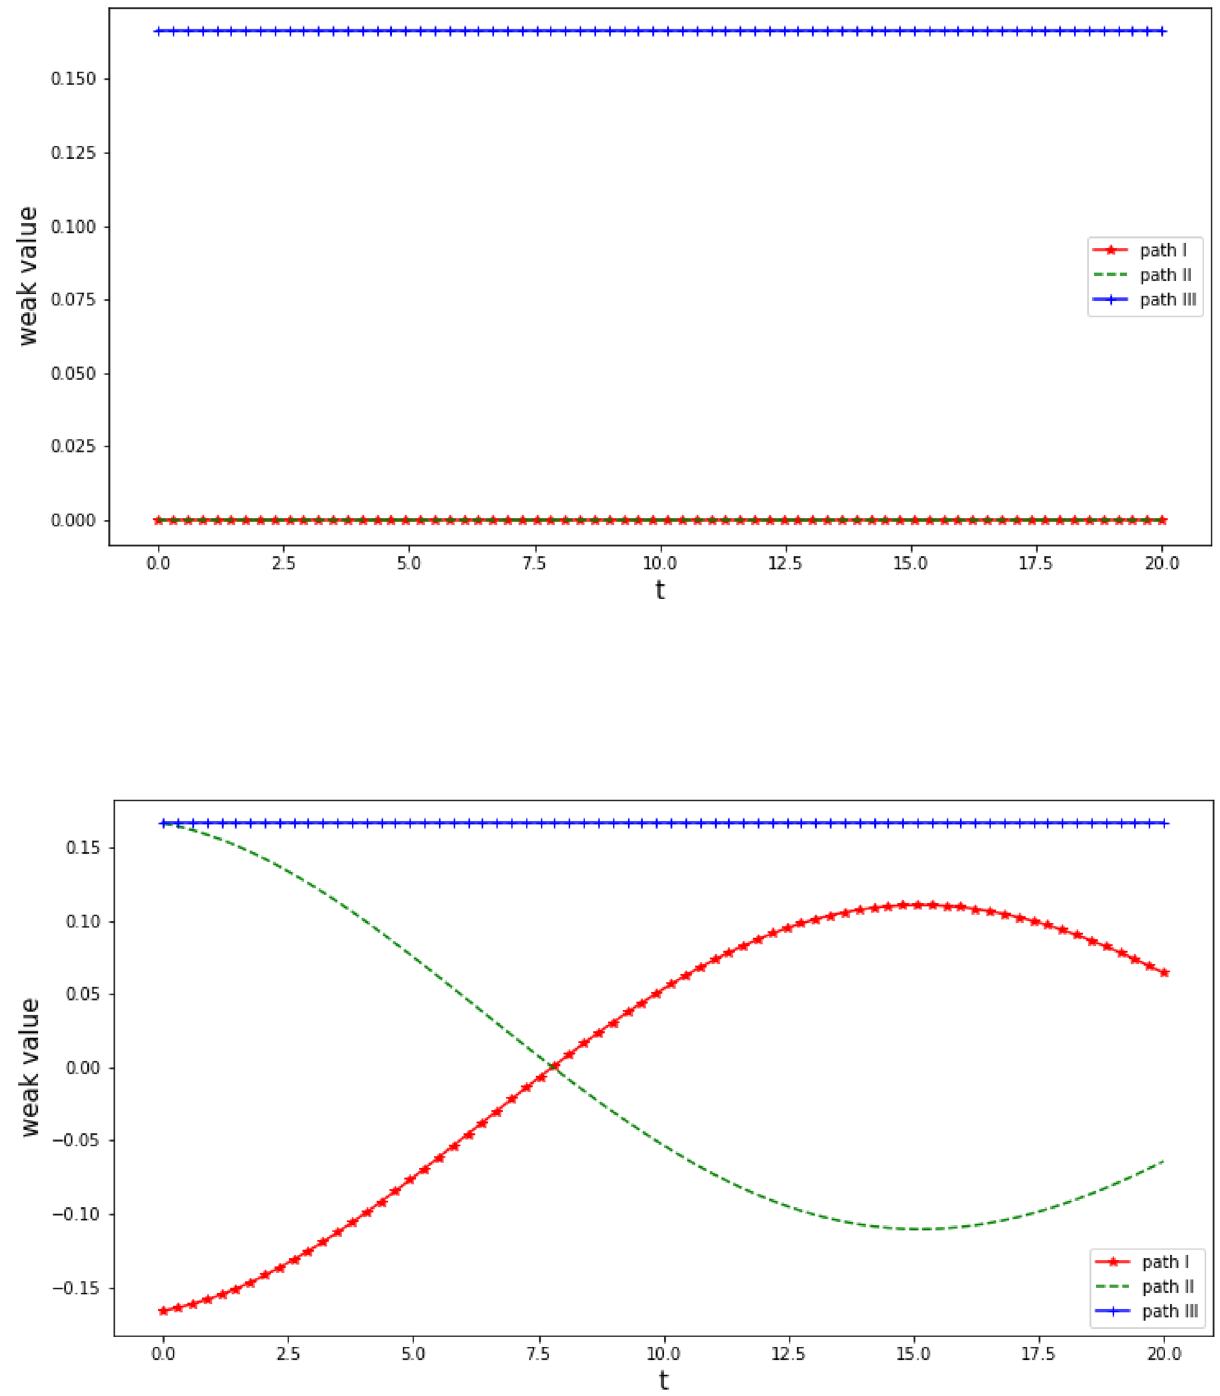
I (cid:31) I,II,III Figure 2. Weak values of w Eq. (14) upper panel at instants A and C , cf. Fig. 1, for a pre-and a 2 � ⊗ � postselection given in Eqs. (20) and (22) respectively and, lower panel , at B for a pre-and postselection given in Eq. (21) as a function of duration of particle-environment interaction. Time is given in 1 /ω c and we set ε